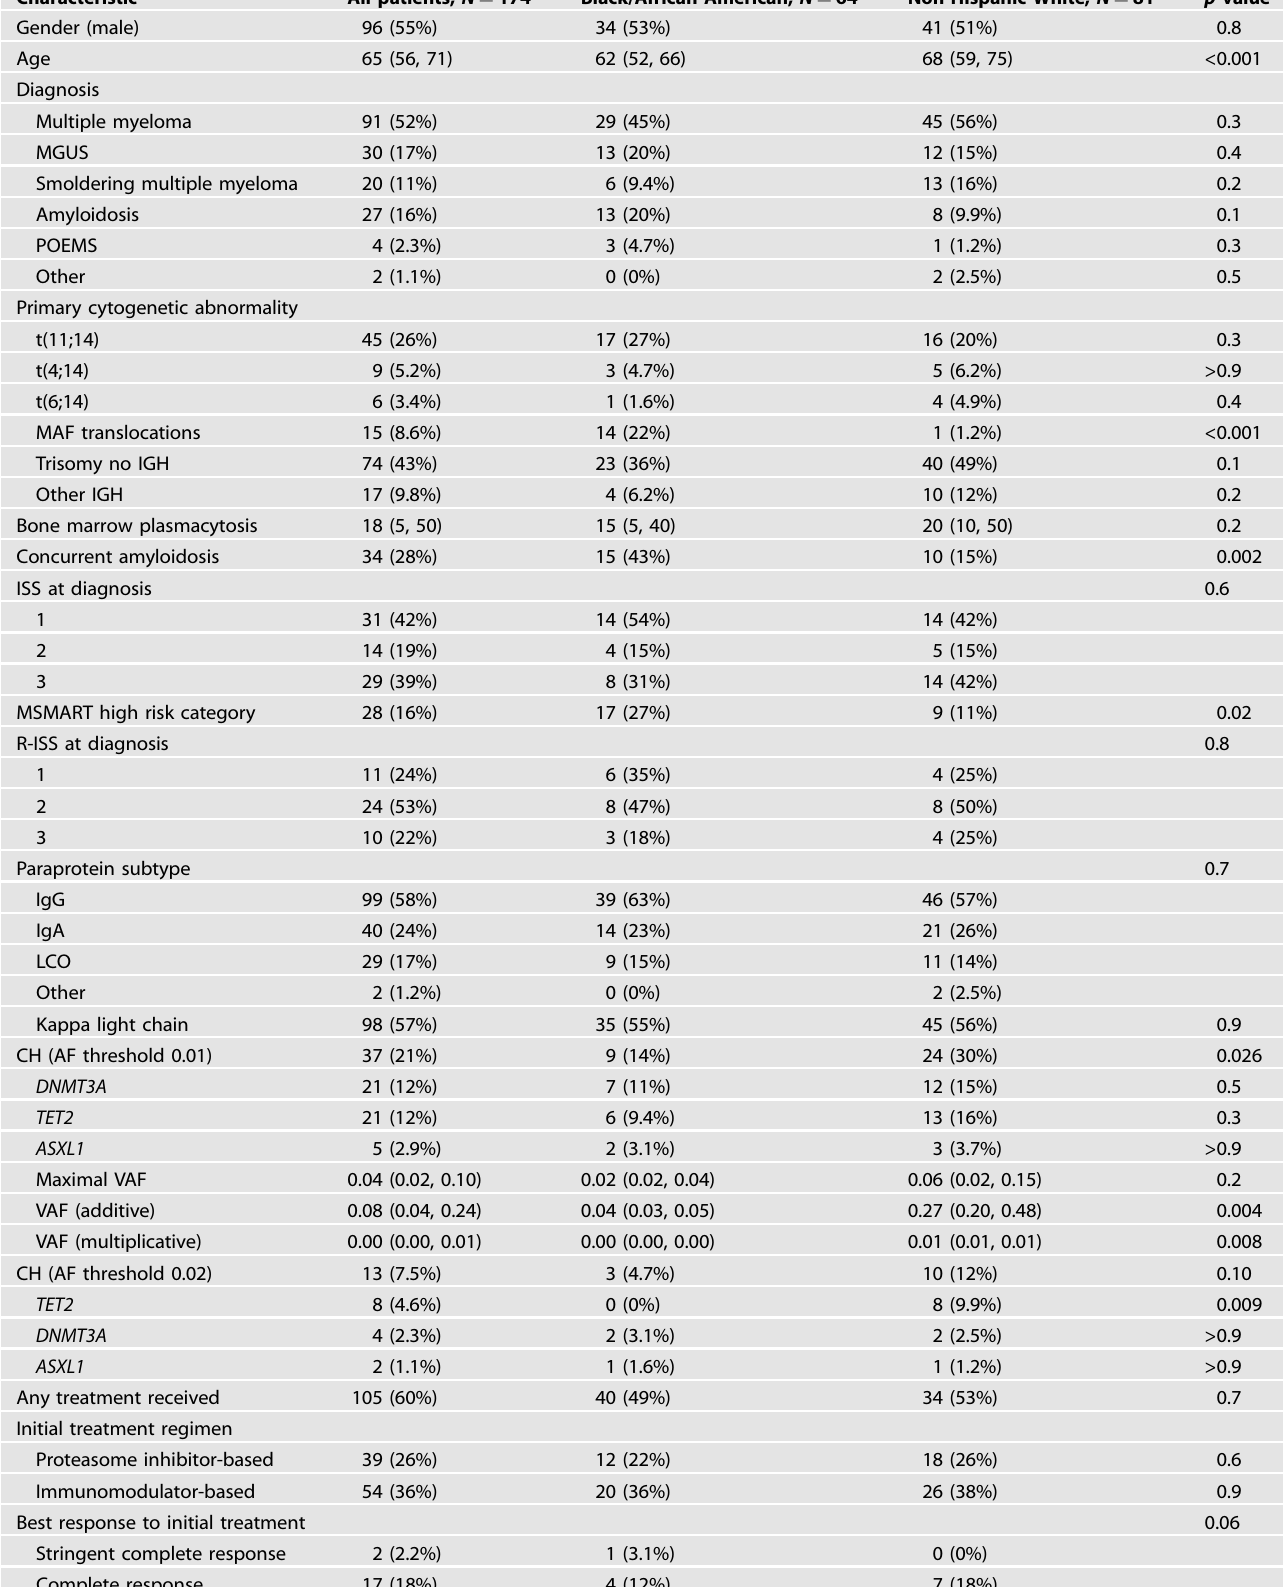
Table 1. Characteristics and baseline demographics of study cohort ( n = 174).